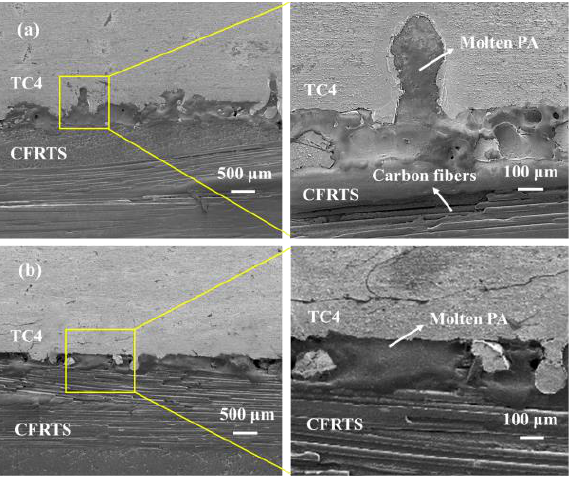
Figure 15. ( a ) Sample 3 interface morphology; ( b ) sample 1 interface morphology.